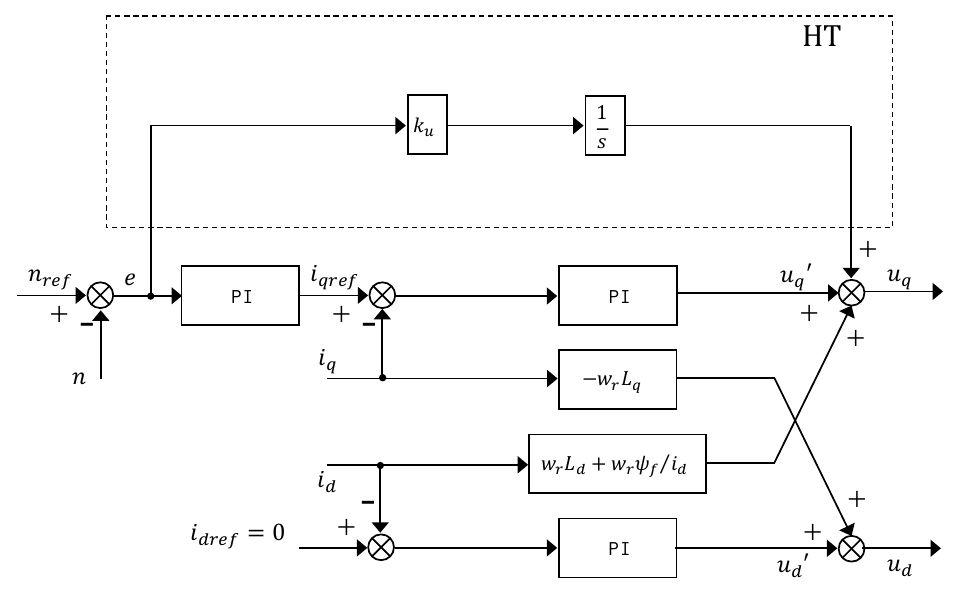
Figure 4. Structure of HT based on feed-forward decoupling